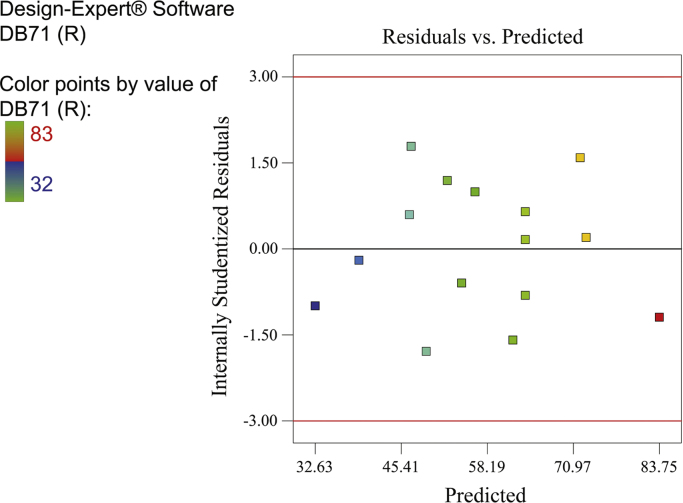
Plot of residual values vs. predicted response values.